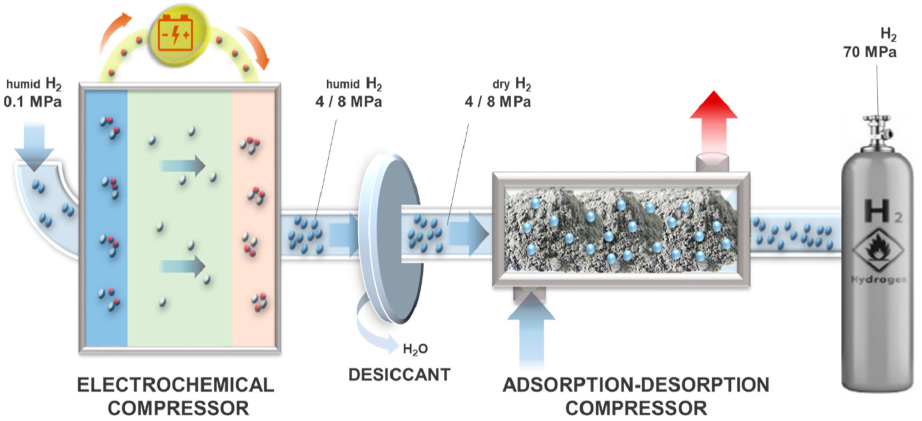
Figure 8. Schemeofahybridhydrogencompression: electrochemicalatlowpressure,adsorption–desorption Figure 8. Scheme of a hybrid hydrogen compression: electrochemical at low pressure, adsorption– at high desorption at high pressure.